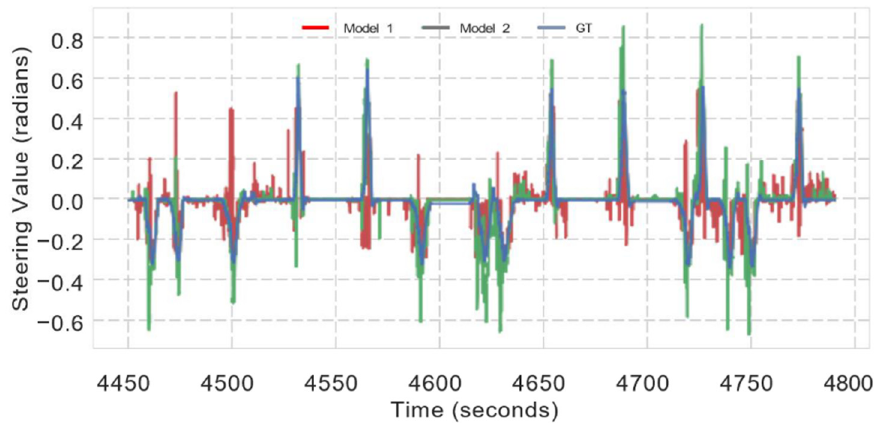
Figure 8. Detailed evaluation of two driving models with the prediction of steering wheel angle.